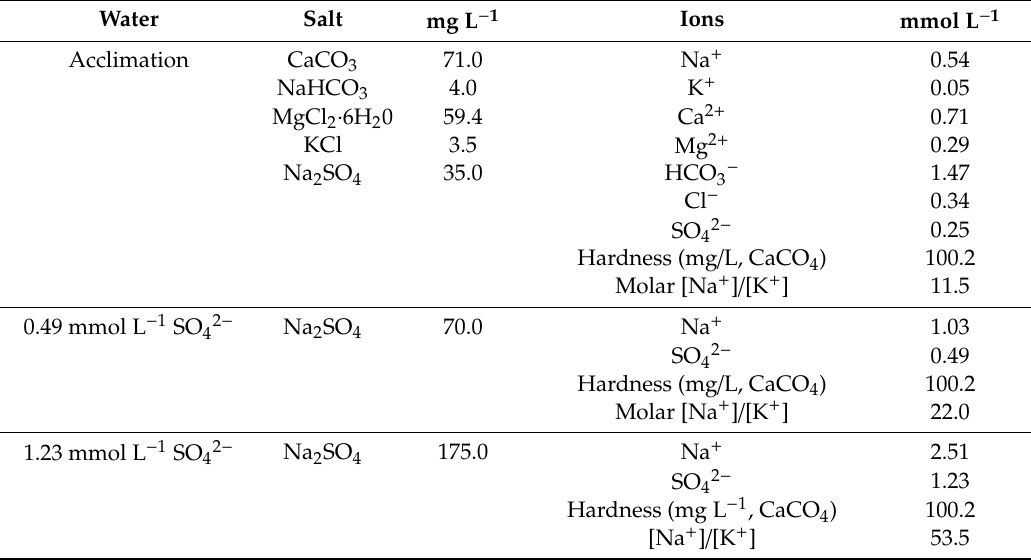
Table 1. Concentrations of salts in the modified moderately hard reconstituted water (MMHRW) used in the experiment along with the resulting target mmol L − 1 of the major ions, along with hardness and the molar [Na + ] / [K + ] ratios. Only the concentrations of Na + and SO 42 − were increased in the MMHRW. Water Salt mg L − 1 Ions mmol L − 1 CaCO